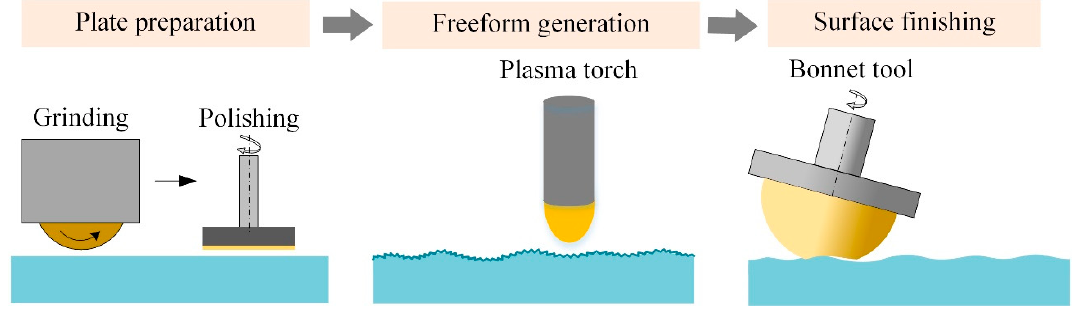
Figure 1. Combining APPP and BP for freeform generation.